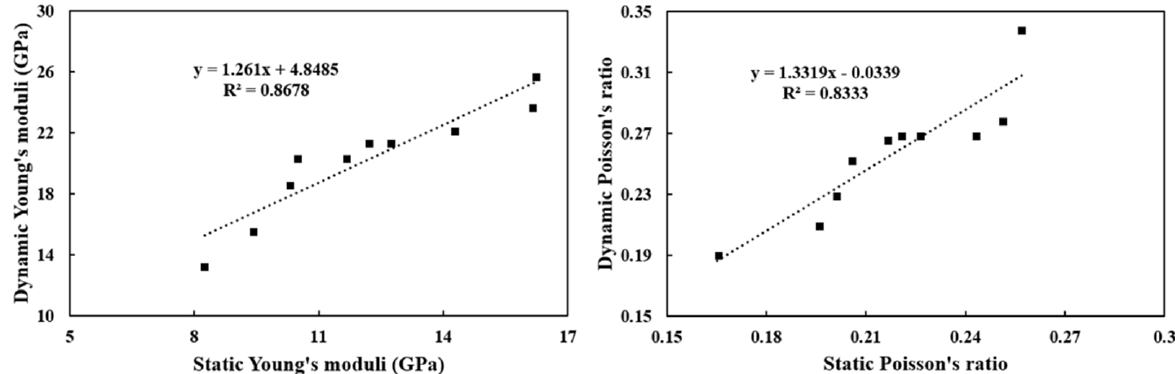
Figure 4. Dynamic and static conversion of Poisson’s ratio and Young’s modulus.